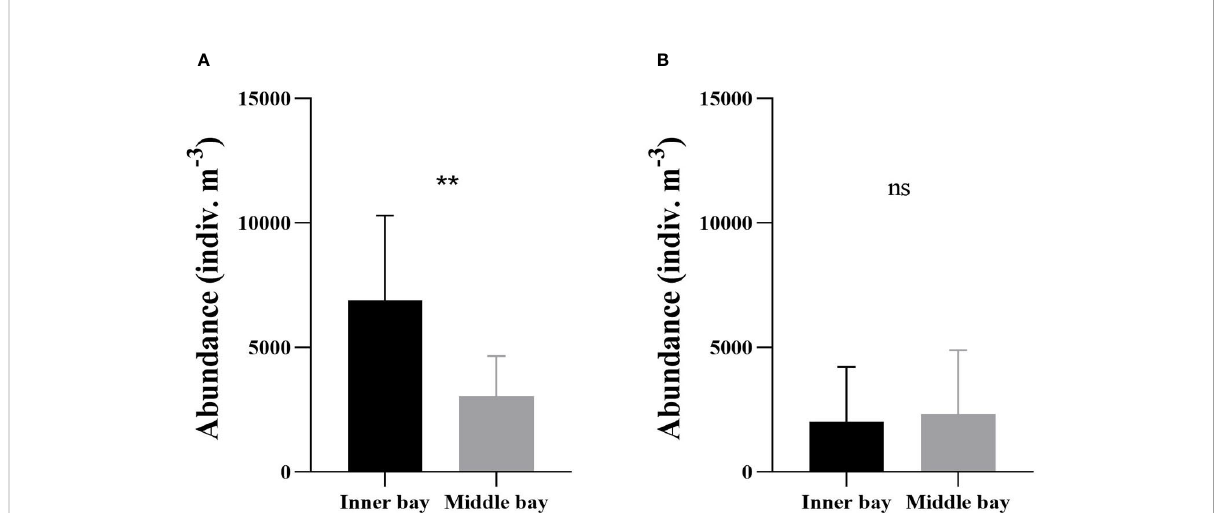
FIGURE 5 Mean mesozooplankton abundance in the inner bay and the middle bay of Gamak Bay during the (A) hypoxic period (from June to September) and (B) normoxic period (from October to May). Spatial differences in mesozooplankton abundance were tested with Mann-Whitney U-tests. Asterisks stand for signi fi cant-difference levels between inner and middle bay: ** p < 0.01; ns, not signi fi